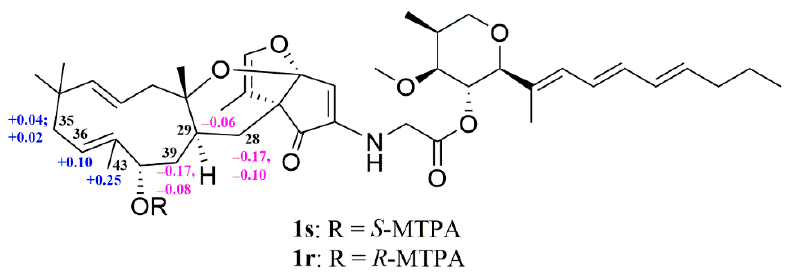
Figure 3. The ∆ δ S - R values of the 1 H NMR chemical shifts of the MTPA esters ( 1s and 1r ) of penipyridinone B ( 1 ).